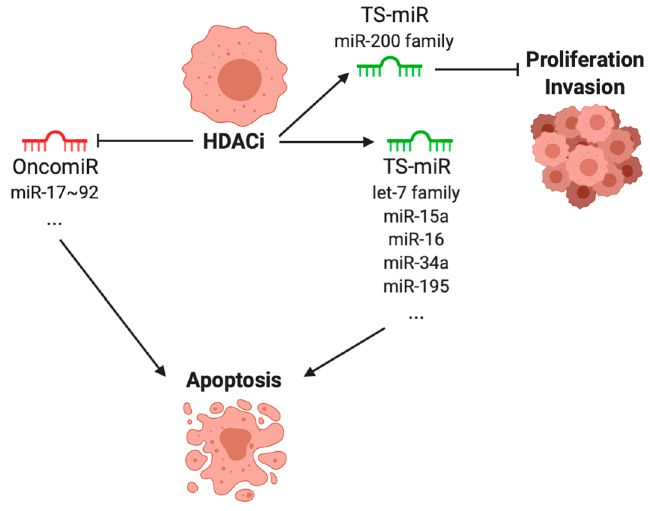
Figure 2. miRNAs modulated by HDACi treatments in cancer. HDACi upregulate TS-miR and downregulate oncomiR to inhibit proliferation and metastasis and to favor apoptosis.